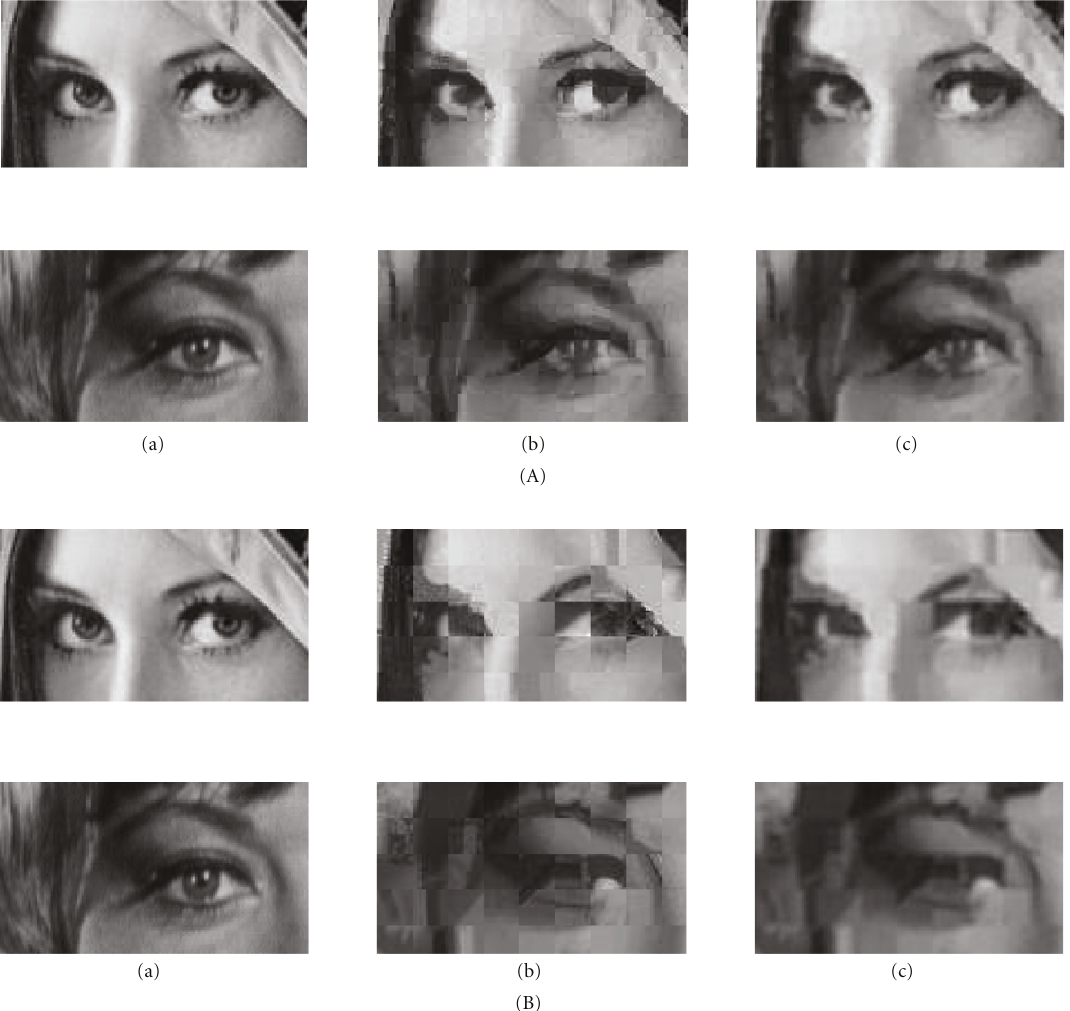
Figure 13: (A) Cropped (a) original, (b) reconstructed, and (c) filtered versions of the images (Lenna and F73) for the 1st group of experiments (Fold 1). Lenna: PSNR = 28,93 and 29,66 (filtered), F73: PSNR = 33,36 and 34,11 (filtered) (CR = 21,33). (B) Cropped (a) original, (b) reconstructed, and (c) filtered versions of the images (Lenna and F73) for the 2nd group of experiments. Lenna: PSNR = 25,20 and 25,87 (filtered), F73: PSNR = 29,58 and 30,36 (filtered) (CR =